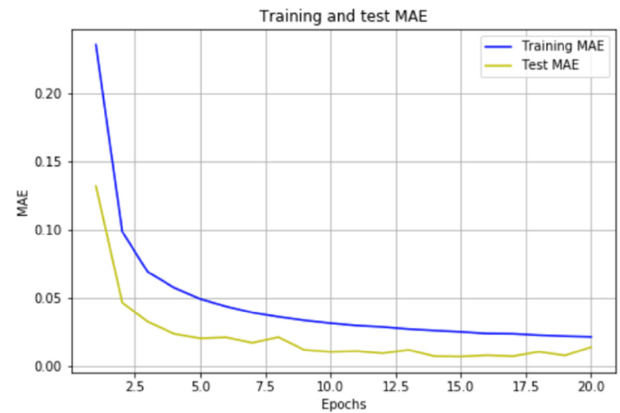
Figure 4. MovieLens . Mean Absolute Error (MAE) quality in the prediction of the reliabilities. Figure 4. MovieLens. Mean Absolute Error (MAE) quality in the prediction of the reliabilities.